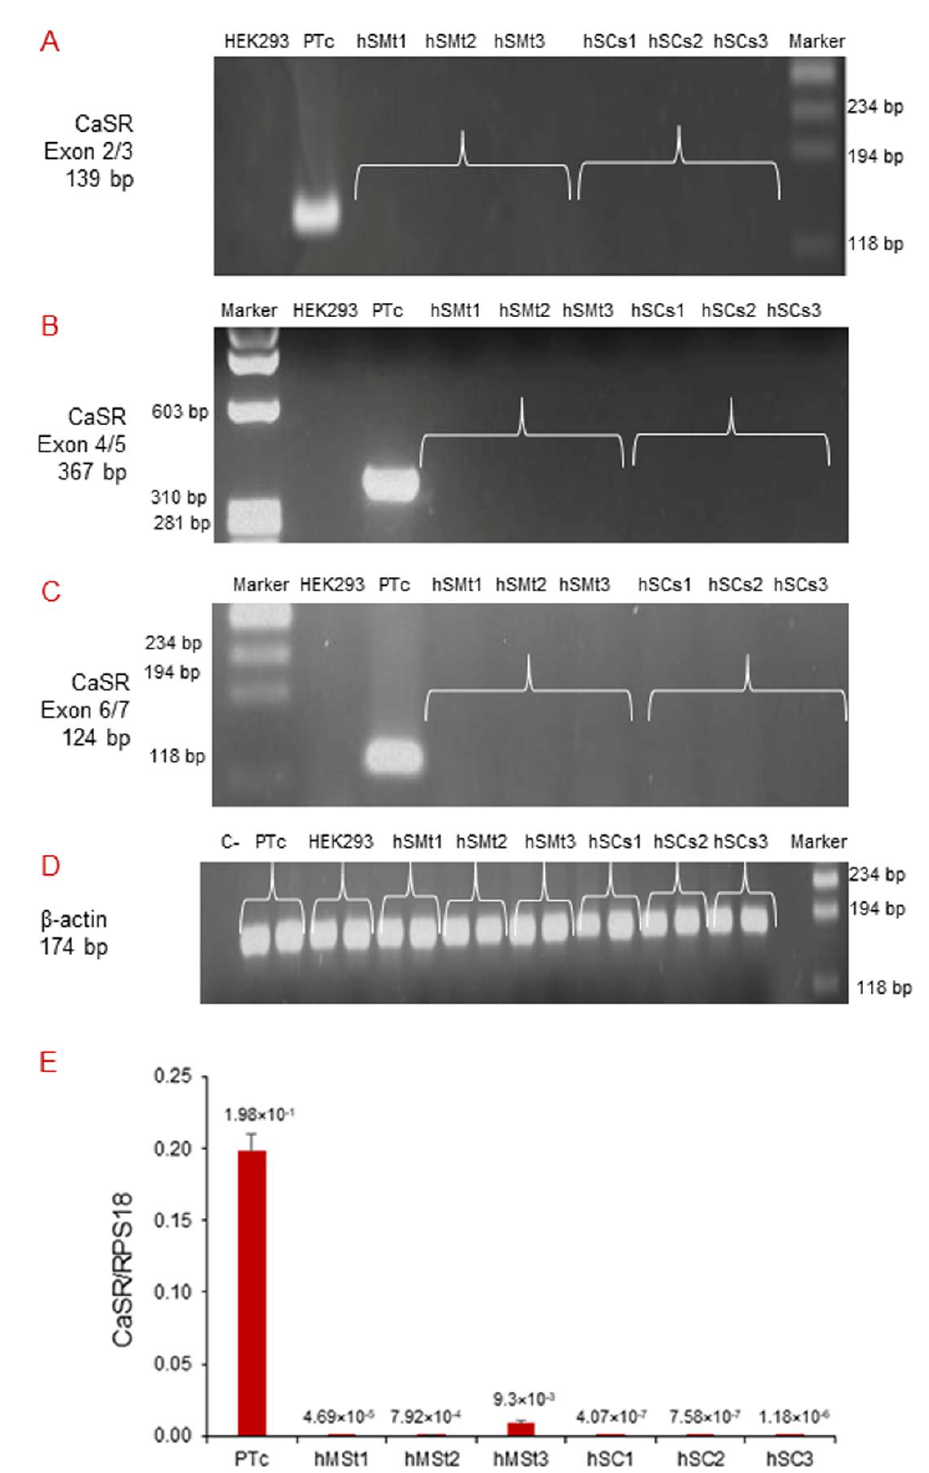
Figure 3. Molecular analysis of CaSR gene expression in hSMts and established hSC lines. The analysis in RT-PCR showed the expression of CaSR gene using different pairs of primers that fall into: ( A ) exons 2/3; ( B ) exons 4/5; ( C ) exons 6/7. The gene was not detected in any of the samples. The analysis shows the presence of CaSR only in human PTcs that were used as a positive control. HEK293 were used as a negative control. Housekeeping β -actin gene analysis of the assayed samples ( D ). Real-time qPCR analysis of CaSR gene in hSMts and in hSC lines. The analysis showed a very low expression of CaSR gene in hSMts and in hSC lines. PTcs were used as positive control ( E